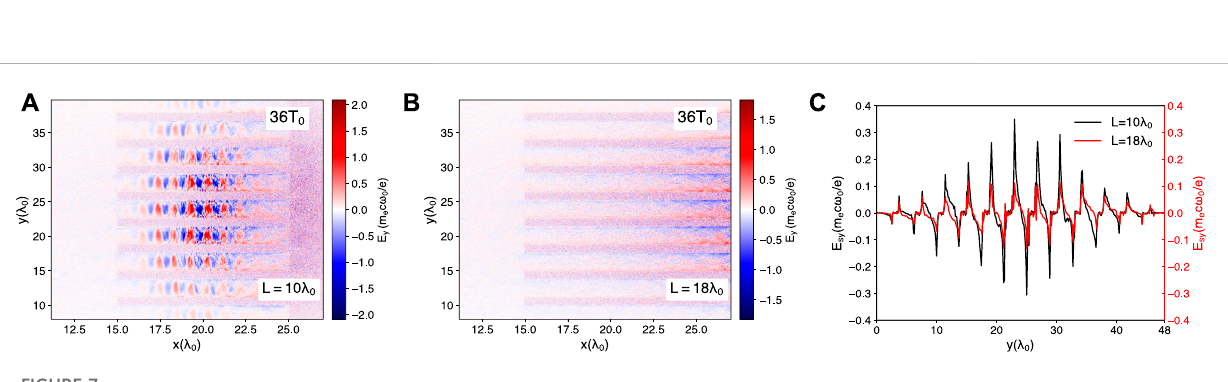
FIGURE 7 (A) For the fi xed L = 10.0 λ 0 , S = 2.8 λ 0 , D = 1.0 λ 0 , the laser electric fi eld at t = 36T 0 . (B) For the fi xed L = 18.0 λ 0 , S = 2.8 λ 0 , D = 1.0 λ 0 , the laser electric fi eld at t =